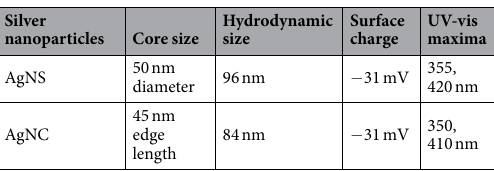
Table 1. Physicochemical characterization of silver nanoparticles.